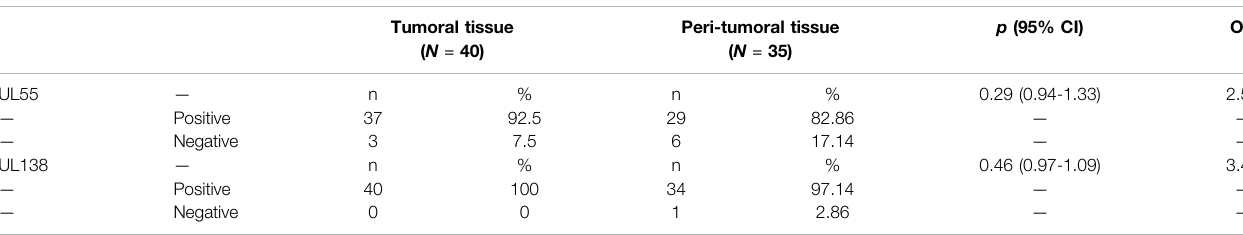
TABLE 3 | Prevalence of HCMV in both types of tissue.